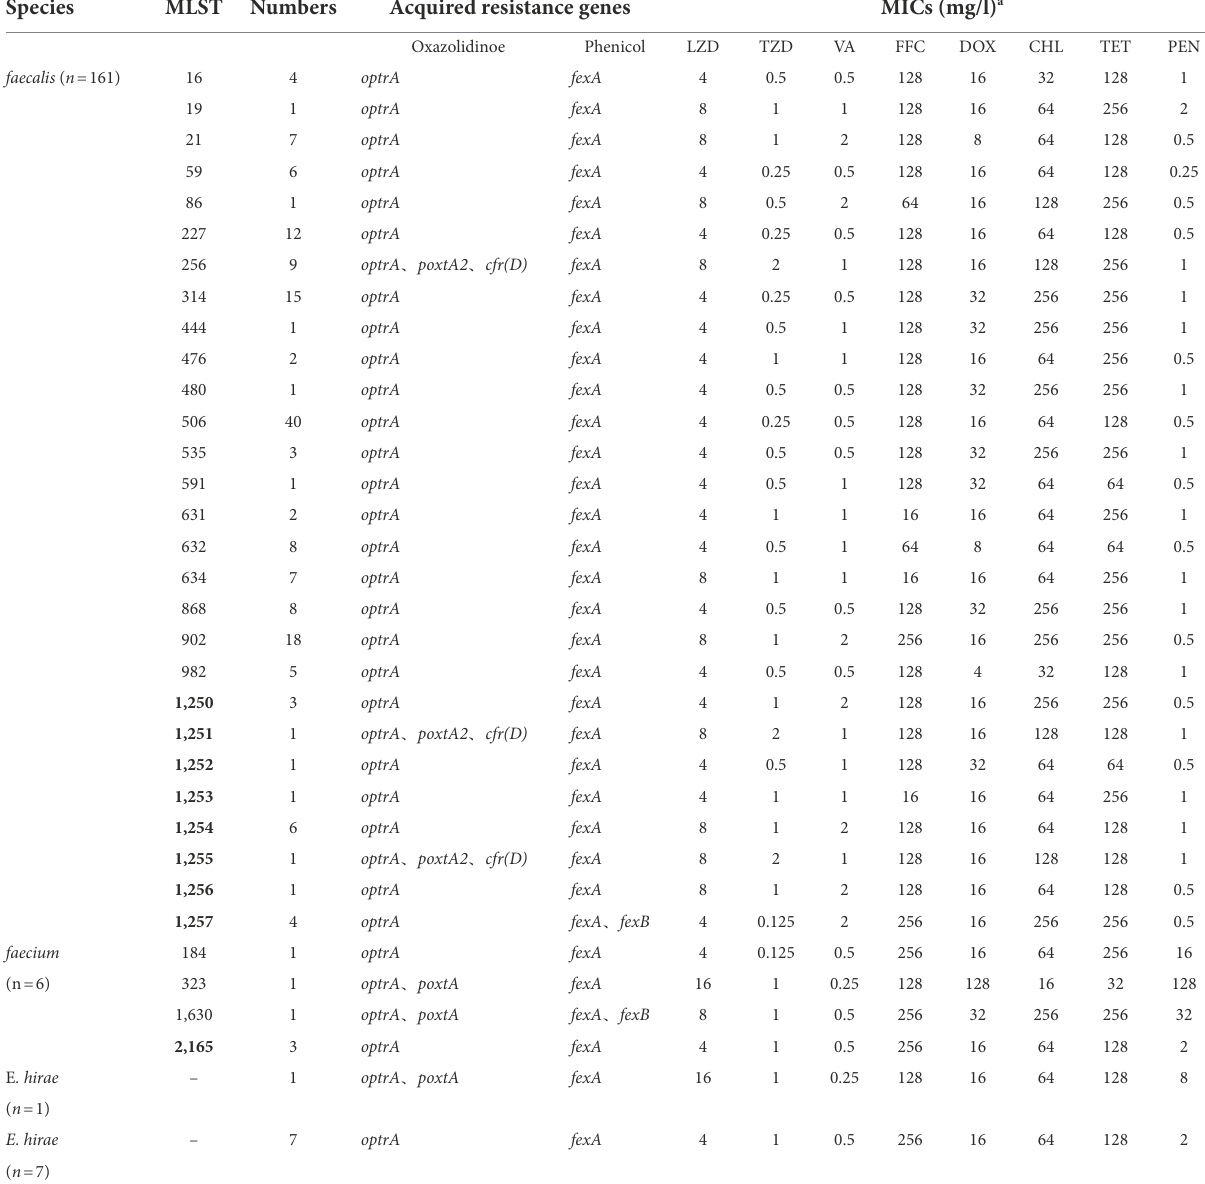
TABLE 1 Enterococcal isolates that harbored oxazolidinone resistance genes in this study. Species MLST Numbers Acquired resistance genes